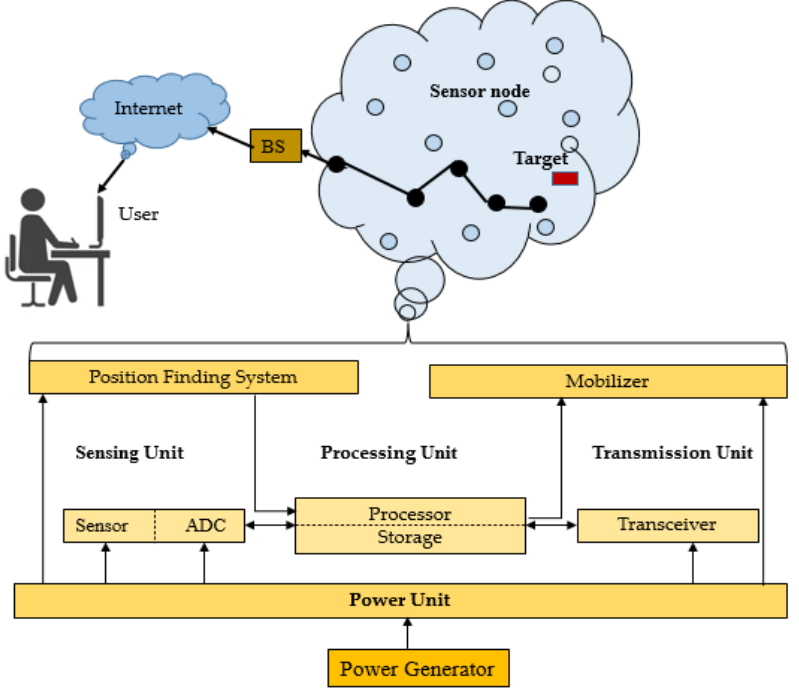
Figure 1. WSN architecture for communication.